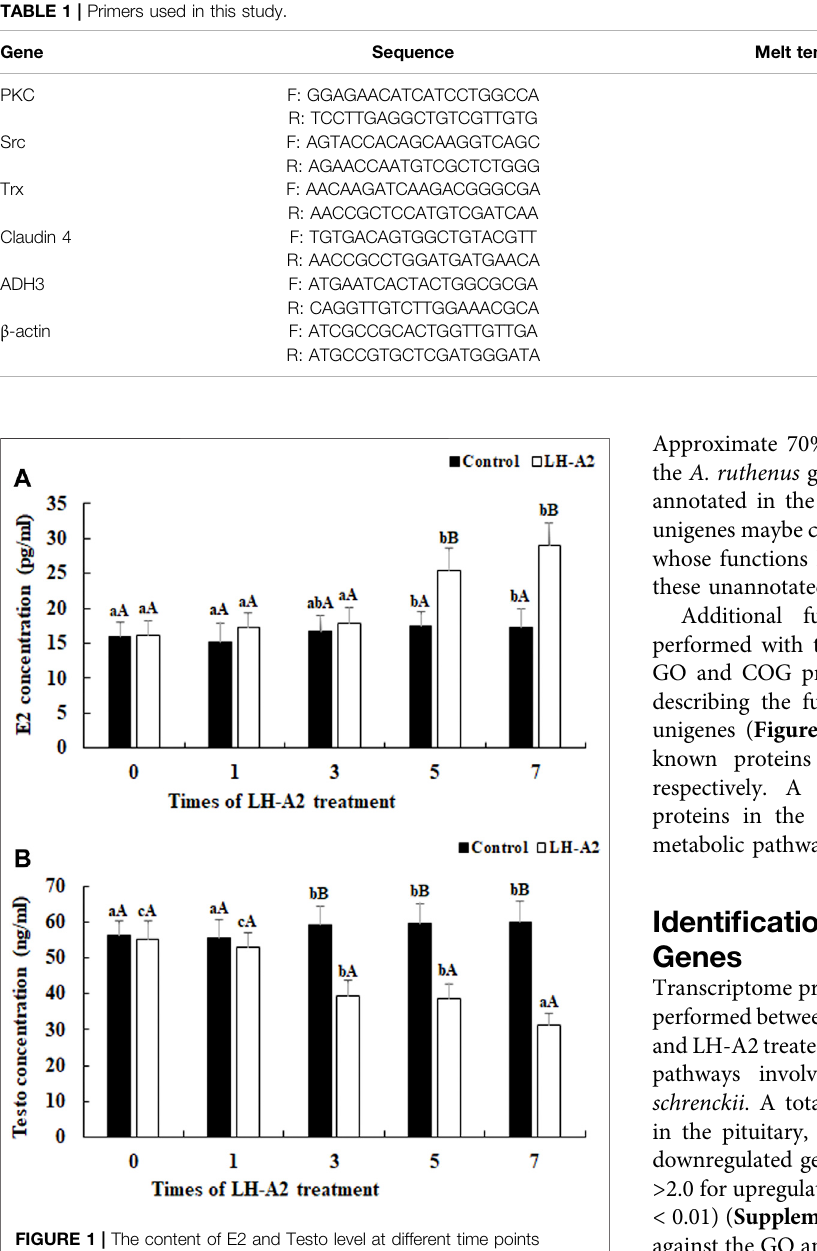
FIGURE 1 | The content of E2 and Testo level at different time points after thetreatment ofLH-A2at thedose of3 μ g/kg. Lowercasesindicated the signifcant difference between different time points in the same treated group, and capital letters indicated the signi fi cant difference between control groupandLH-A2grouponthesameday( p < 0.05). (A) ThecontentofE2; (B) The content of